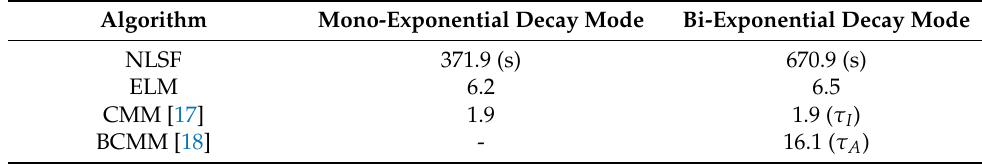
Table 1. Time Consumption (Seconds) of NLSF And ELM for Inference Lifetime Parameters.